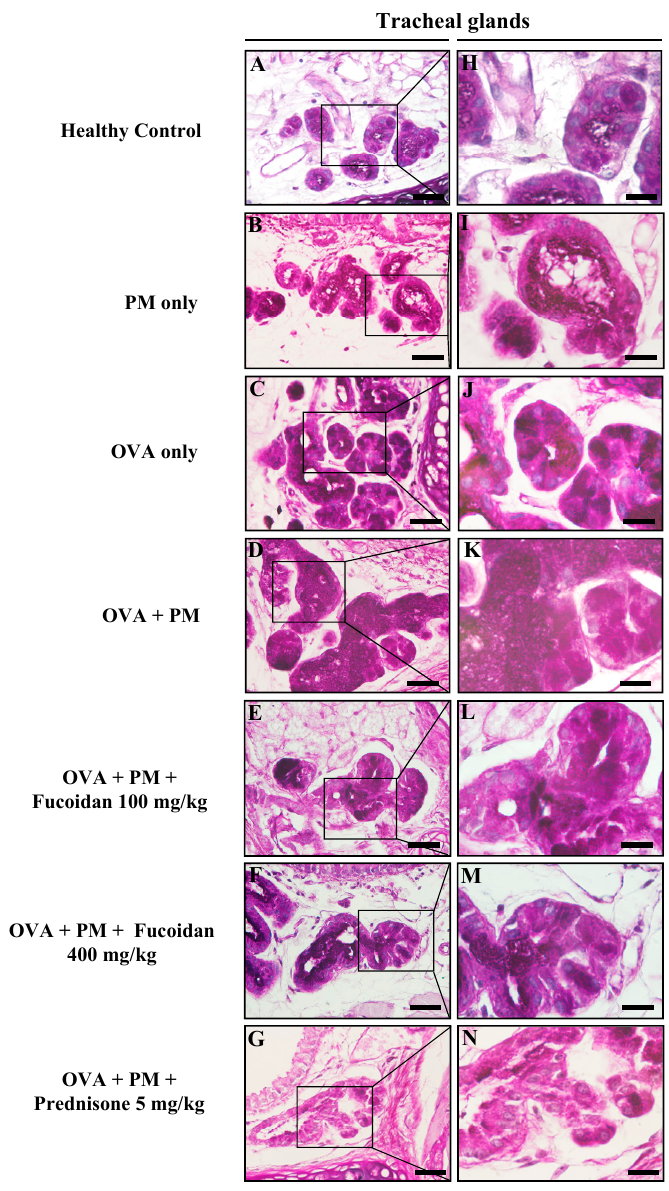
Figure 11. The e ff ect of fucoidans on ( A – N ) mucus secretion in submucosal glands in the trachea of PM-exposed mice. Representative figures of ( A , H ) the healthy control, ( B , I ) PM only, ( C , J ) OVA only, ( D , K ) OVA + PM, ( E , L ) OVA + PM + Fucoidans (100 mg / Kg), ( F , M ) OVA + PM + Fucoidans (400 mg / Kg), ( G , N ) OVA + PM + Prednisone (5 mg / Kg). The scale bar of ( A – G ) is 25 µ m, and ( H – N ) were captured by an oil immersion lens (magnification ×